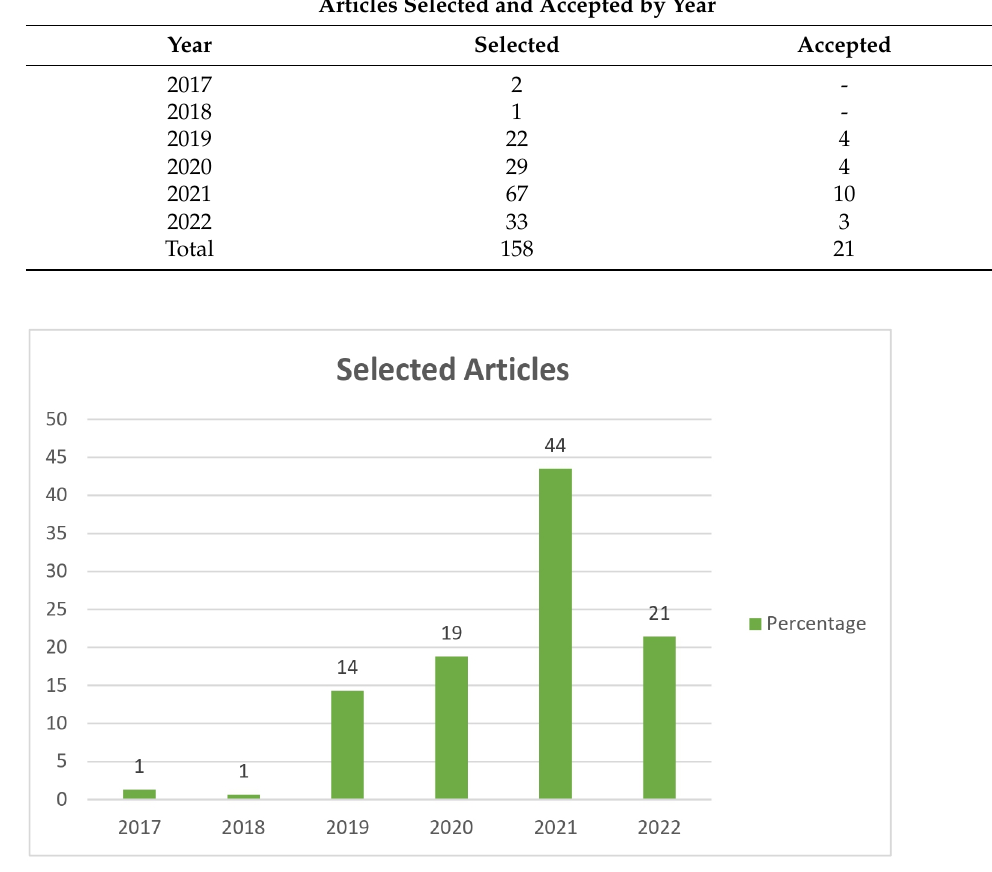
Figure 4. Percentage of articles selected.